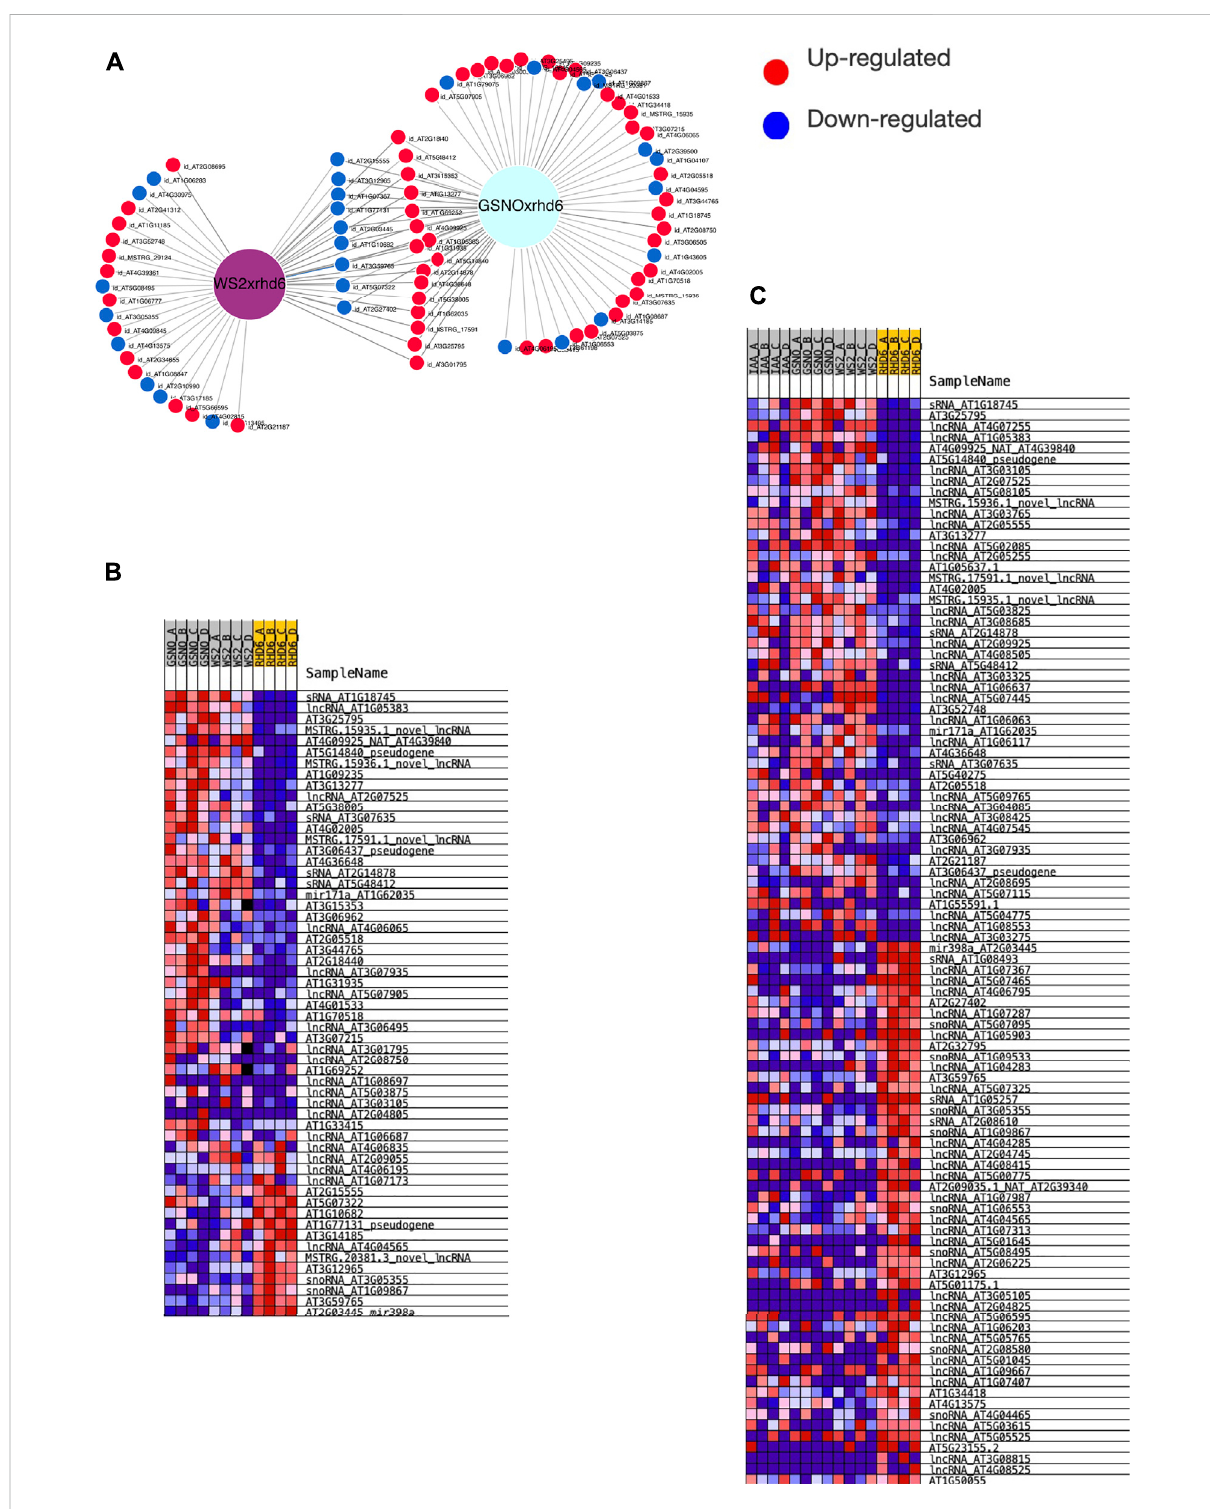
DifferentiallyexpressedgenesinGSNO-treatedandWS-2 seedlingsandtheirpotentialparticipationintherestoration ofroothairphenotypein rhd6 mutants. (A) Intersection of differentially expressed genes (DEGs) detected in the comparison between GSNO-treated rhd6 vs. untreated rhd6 and WS-2 vs. rhd6 reveals 25 genes in common for GSNO-treated rhd6 and WS-2 seedlings, of which nine are downregulated and 16 are upregulated. (B) Gene set enrichment analysis (GSEA) performed for GSNO-treated rhd6 /WS-2 vs. untreated rhd6 groups. Figure shows DE genes are enriched and contribute with similar expression patterns for the WS-2 root hair formation (RHF) phenotype. (C) GSEA performed for GSNO-treated/IAA-treated/WS-2 vs. rhd6 groups. Figure shows the top 50 genes contributing the most in GSNO- and IAA-treated for the recovery of RHF phenotype observed in